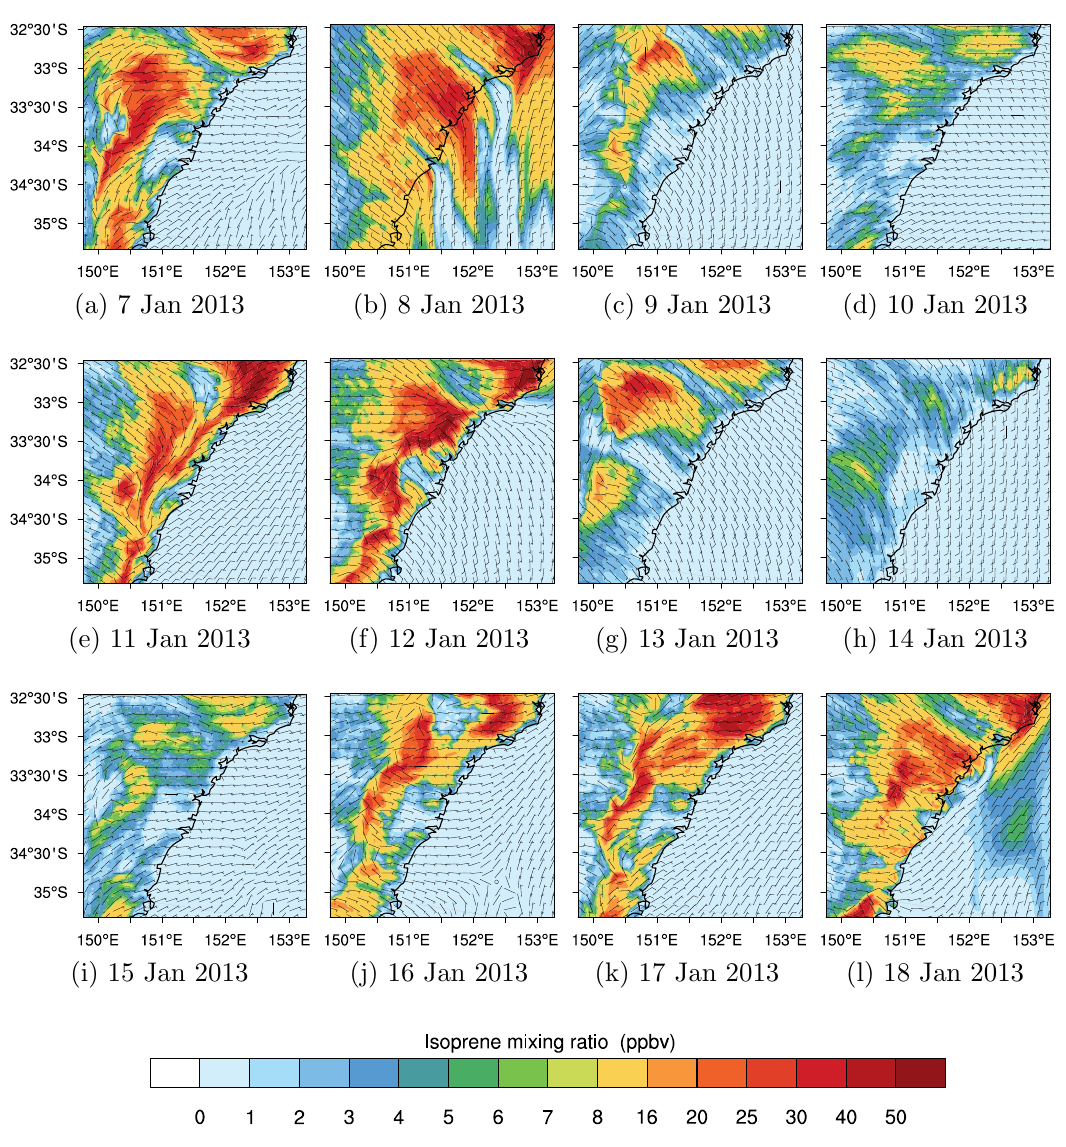
Figure 8. Simulated surface isoprene from 7 January to 18 January 2013 at 3:00 p.m. local